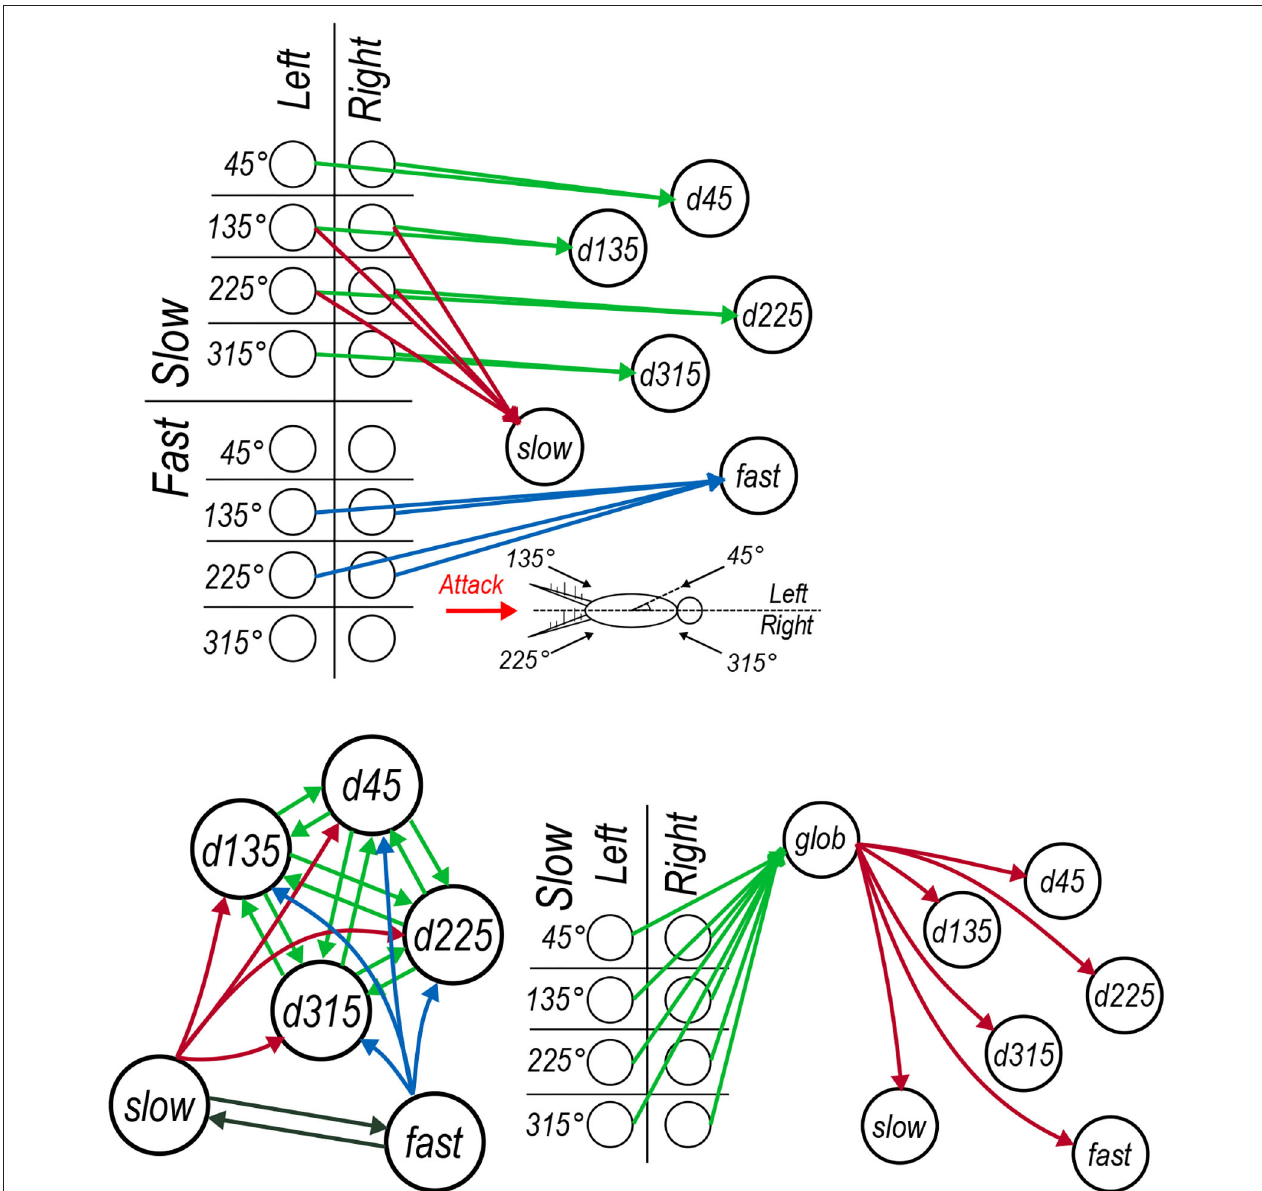
FIGURE 4 | Architecture of the cercal system escape response model. Colors of synaptic connections do not correspond to synaptic inhibition or excitation but instead are used to help distinguish between sets of synapses. (A) The feed-forward connections between each of the input layer neurons and the six interneurons each of which encodes a particular property of the input. (B) The lateral connections between interneurons, including the (green) mutual connectivity between the directionally selective neurons, (red and blue) the lateral connections from the air speed sensitive neurons onto the directionally selective interneurons and (black) the mutual lateral connections between the air speed sensitive neurons. (C) The global regulation network which receives (green) synapses from all of the low frequency air current input layer neurons and sends regulatory synaptic connections to each of the six interneurons.